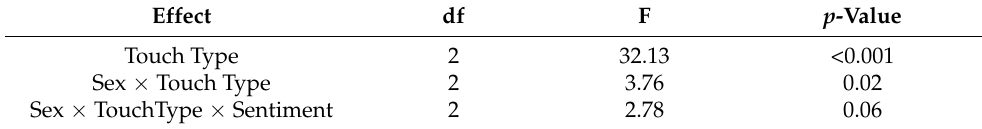
Table 3. Significant main effects on change in physiological arousal from remote touch (all